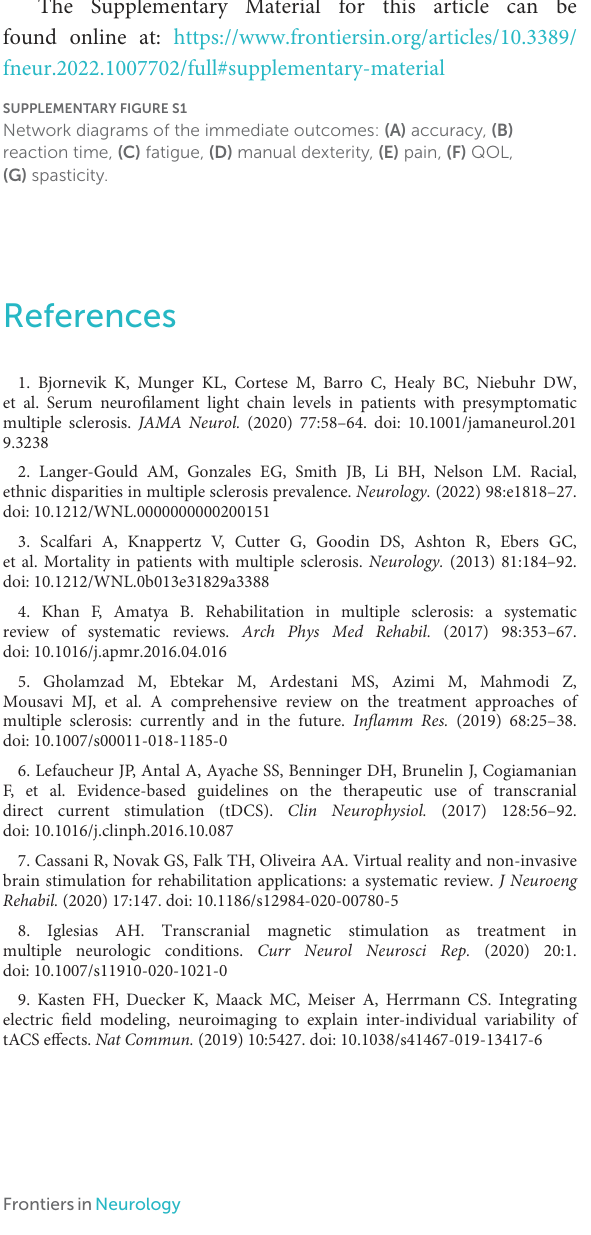
SUPPLEMENTARYTABLE1 Search items and search details. SUPPLEMENTARYTABLE2 Standardized pre-defined data extraction form. SUPPLEMENTARYTABLE3 League table of comparisons the immediate effect between all interventions for outcome parameters: (A) accuracy, (B) reaction time,